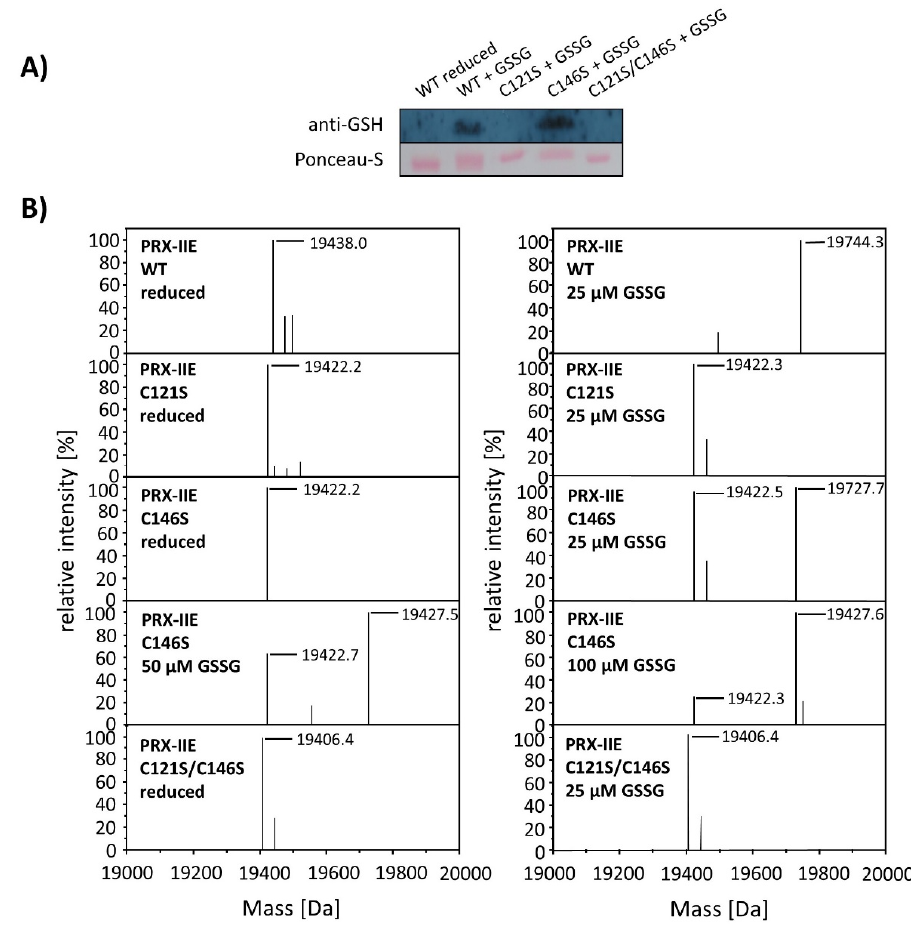
Figure 7. Identification of the S-glutathionylated Cys residue in PRX-IIE using Cys → Ser variants. To test for the site of glutathionylation, Cys → Ser mutated PRX-IIE variants were analyzed by Western blot with specific anti-GSH antibody and by mass spectroscopy. ( A ) 10 µM reduced WT PRX-IIE and variants (C121S; C146S; C121S/C146S) were incubated with 10 mM GSSG for 1 h at RT and subjected for Western blot analysis. ( B ) Representative deconvoluted ESI-MS spectra of PRX-IIE and variants treated with GSSG. 19438 Da corresponds to the theoretical mass of the reduced and His-tagged protein, whereas a shift of 306 Da to 19,744 was observed for the glutathionylated version of PRX-IIE with a single bound glutathione molecule. 19,422 Da corresponds to the reduced variants with single mutated cysteinyl residues (C121S; C146S) and 19,406 Da to the double mutant. Only the C146S protein, lacking the Cys R , was glutathionylated in a concentration-dependent manner. The figure shows representative spectra of n = 6 determinations, using protein from two independent